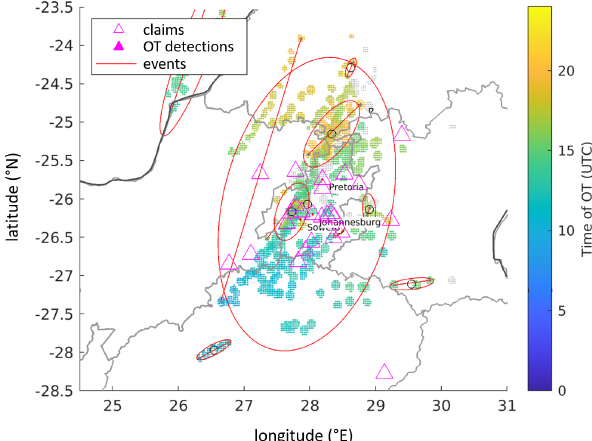
Figure 6. Convective storm activity in the Gauteng region of South Africa on 28 November 2013. Filtered OTs (gray dots), retained OTs (color-coded by time), hail claims (pink), and event definition (ellipses). Hail claims (magenta) indicate the location of successive hailstorms, split by the algorithm into three events, for which el- lipses show the spatial extent. A line connects the locations of the initial and final OT locations, determining the orientation of the el- lipse. Two smaller events overlap the main event centered over the Gauteng region, as the associated cells developed at a later time, separately from the main